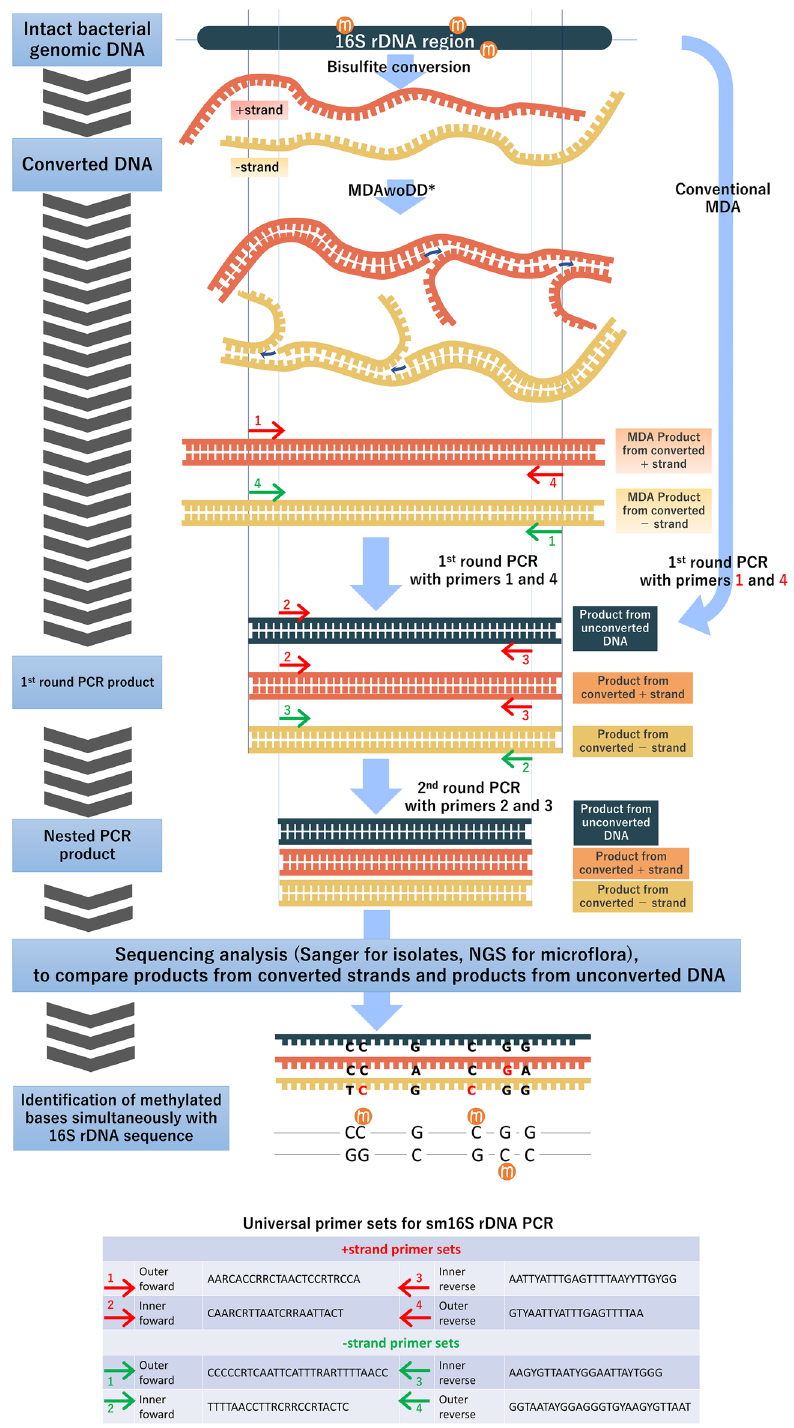
Figure 1. sm16S rDNA PCR and primer sets. The bacterial 16S rDNA V4-V5 region was targeted using bisulfite PCR. Universal nested PCR primer sets were designed to amplify both bisulfite-converted and non-bisulfite-converted DNA. The primer sites were chosen to cover several bacterial species and reduce degenerate nucleotides. *MDA without DNA denaturation (MDAwoDD) was used for the amplification and repair of bisulfite-converted DNA. When amplifying unconverted DNA, the conventional MDA method was used. MDA; multiple displacement amplification. R; A or G. Y; C or T. “m” within the orange circle indicates a methylcytosine